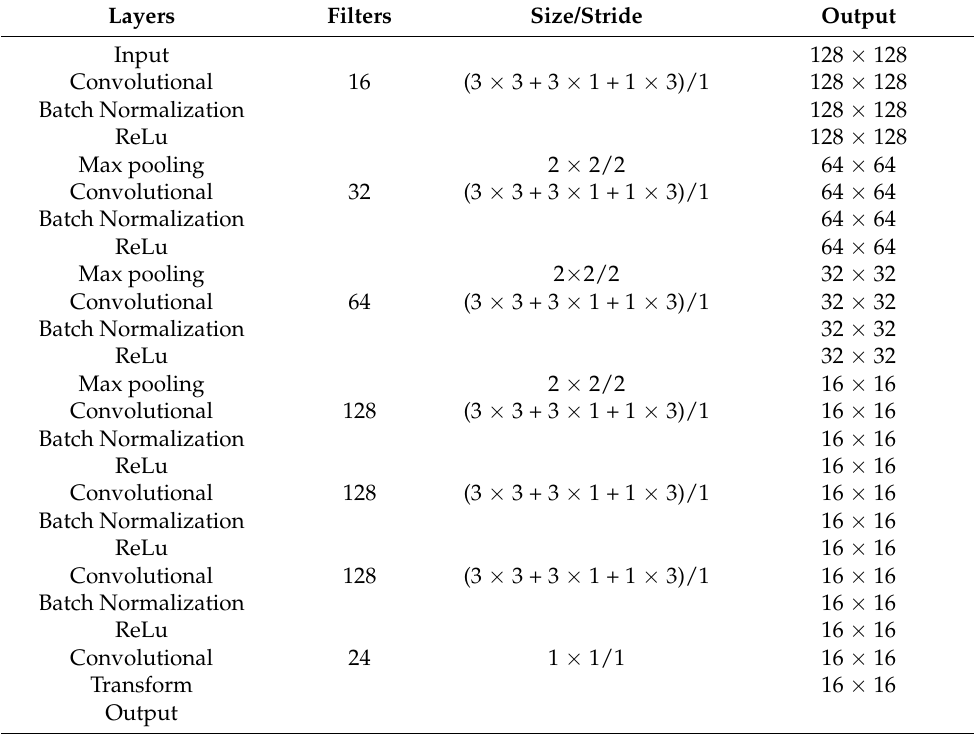
Figure 10. WL polyp detection.